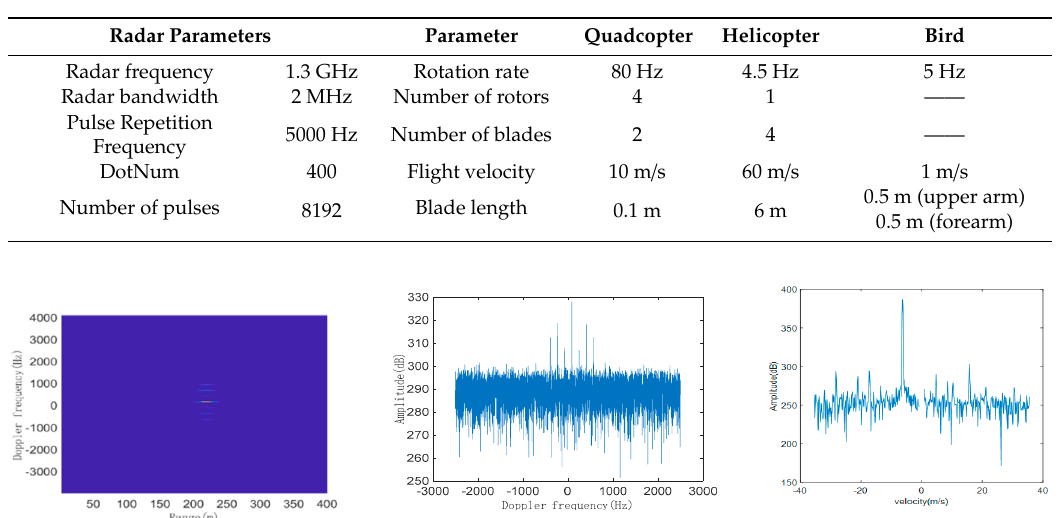
Figure 6. Simulated range-Doppler (RD) plane ( left ), simulated single-frame DMS ( middle ), and real measured DMS ( right ) of quadcopter.